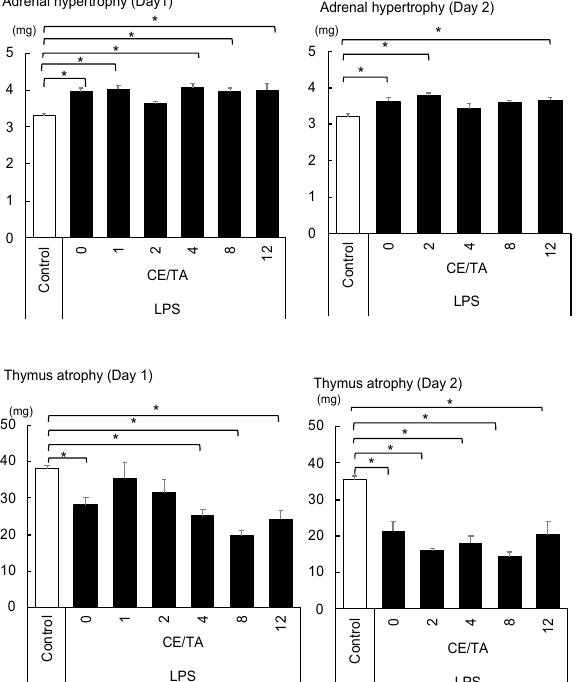
Figure 3. Effect of ingesting green tea component on adrenal hypertrophy and thymic atrophy in LPS-injected mice in 1-day and 2-day experiments. The mice ingested green tea components ad libitum for 6 days prior to LPS injection. Each value represents mean ± SEM ( n = 8, * p < 0.05, Tukey–Kramer method).